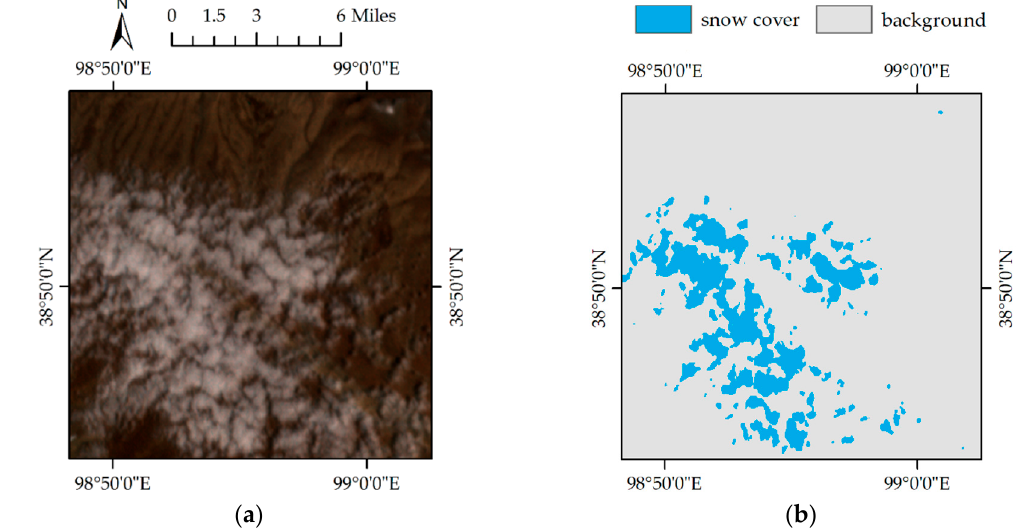
Figure 16. Enlarged views of cloud pixels in the second test site: ( a ) RGB composite image of GF-4 PMS data; ( b ) distribution of snow cover detected by the RSI method. The two subfigures have the same north arrow and scale, which are marked in the upper left corner of the figure.